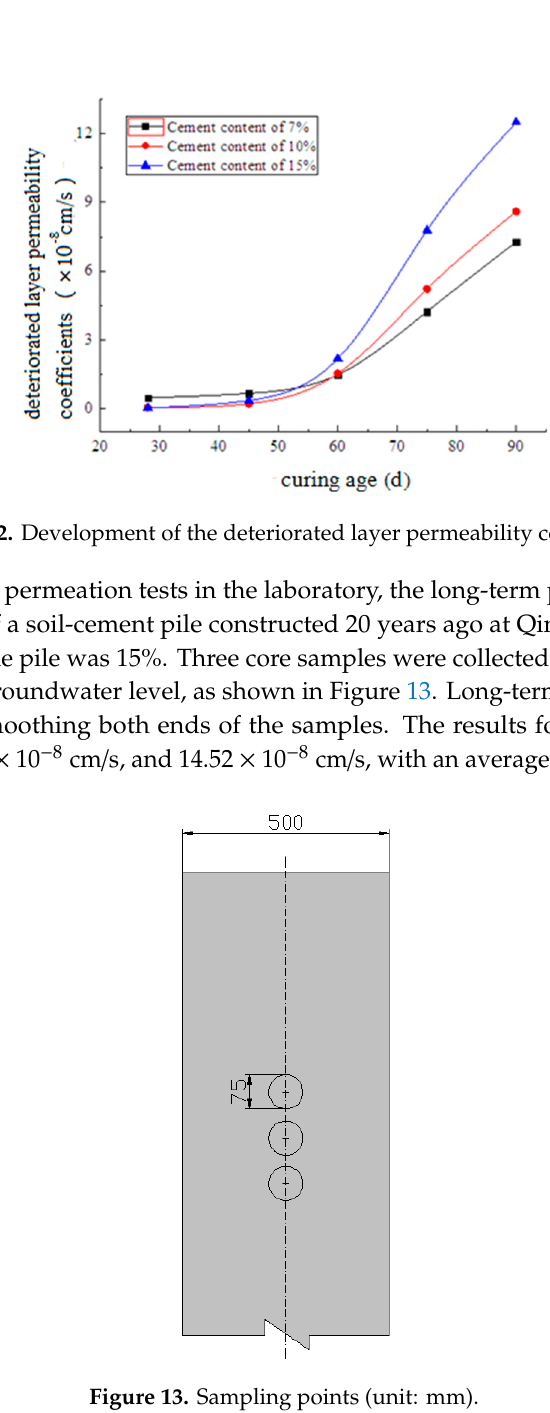
Figure 12. Development of the deteriorated layer permeability coefficients.